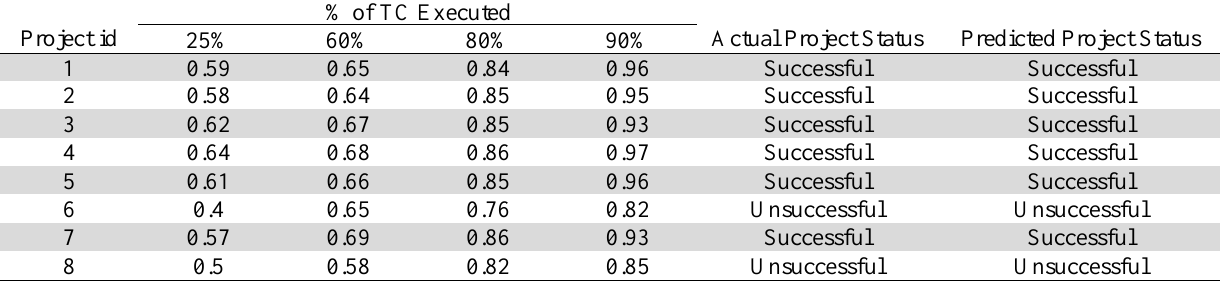
Validation of Results Project